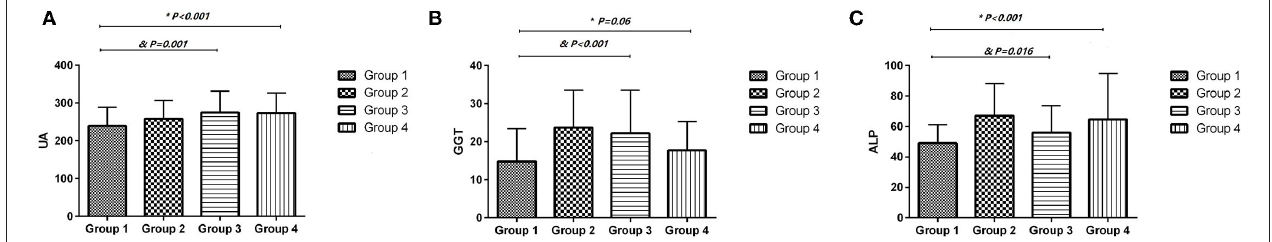
FIGURE 3 | The uric acid, gamma-glutamyl transpeptidase and alkaline phosphatase levels were compared in normal pregnancy (group 1), gestation hypertension (group 3), and preeclampsia (group 4) by One way ANOVA. (A) uric acid (UA); (B) gamma-glutamyl transpeptidase (GGT); (C) alkaline phosphatase (ALP). Chronic hypertension (group 2) was not included for analysis due to small sample size. *Preeclampsia (group 4) compare to normal pregnancy (group1) by One way ANOVA. & Gestation hypertension (group 3) compare to normal pregnancy (group1) by One way